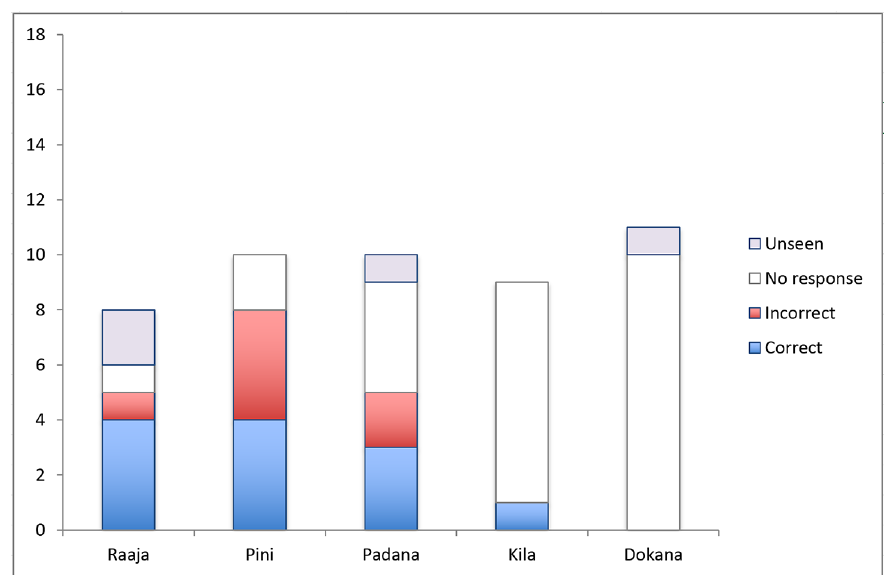
Fig 2. Accuracy of Responses to Bimbo ’ s Points by Females over 18 Trials. Where Bimbo ’ s points could be seen by conspecifics, they received one of three possible responses: no response, an accurate response, or an inaccurate response. No female responded inaccurately numerically more often than accurately. However, due to the small sample-size, no statistical analysis is made.